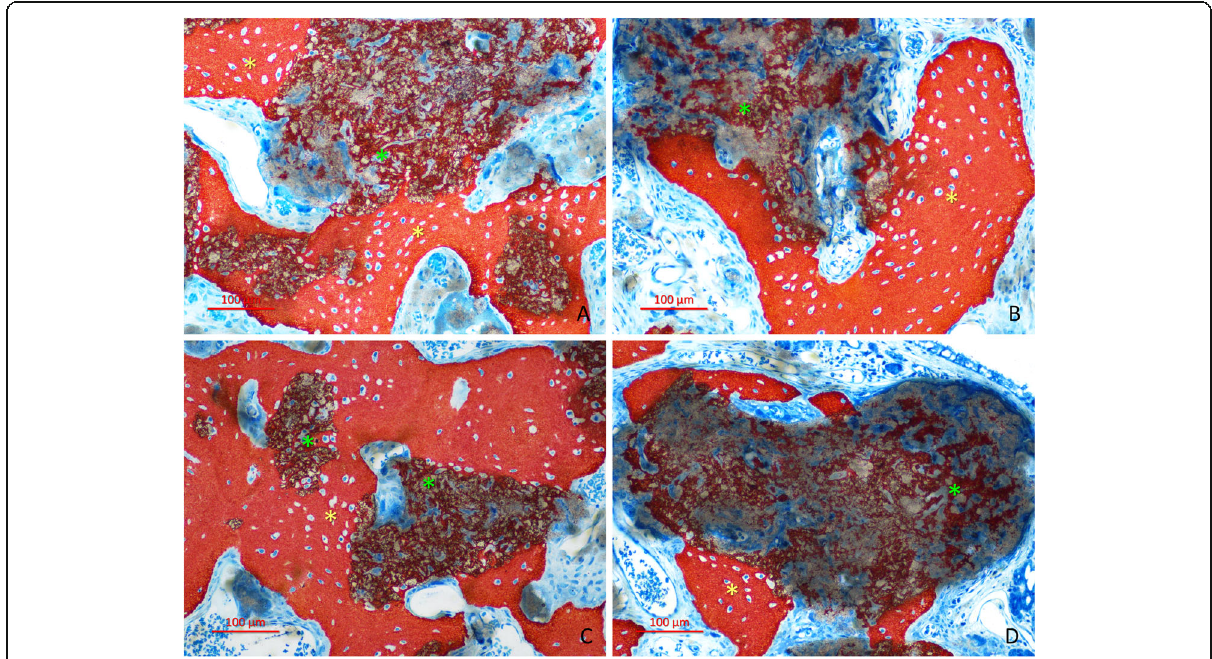
Fig. 3 Healing after 10 weeks. Higher amounts of newly formed bone were observed in this period of healing compared the previous period analyzed, in both the plasma group ( a , b ) and the control group ( c , d ). New bone was penetrating from the peripheral regions (outer bone; OB) inside the remnants of graft particles forming a network of bridges interconnecting the peripheral bone with the biomaterial through its porosities (Interpenetrating bone network; IBN). a Central region. b – d Sub-mucosa regions. c Next to the bone wall region. The asterisks indicate examples of OB (yellow) and IBN (green). Stevenel ’ s blue and alizarin red